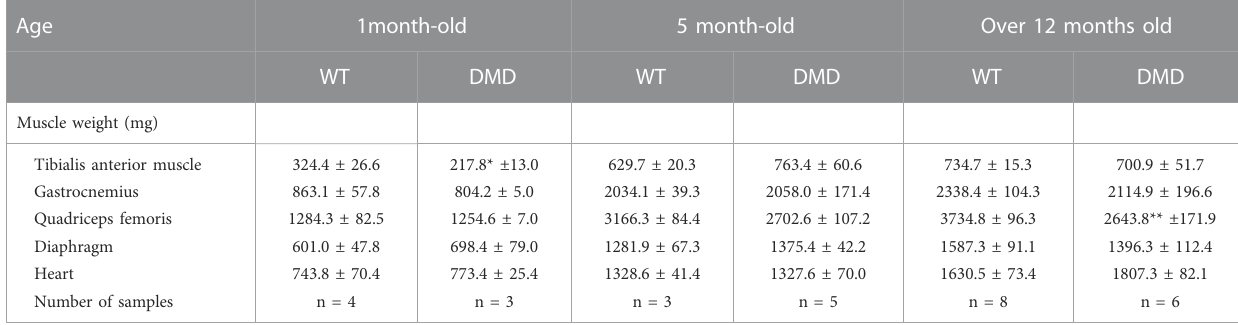
TABLE 1 Total body weight and weights of various skeletal muscles in WT and DMD nude rats at 1, 5, and over 12-month-old. Age